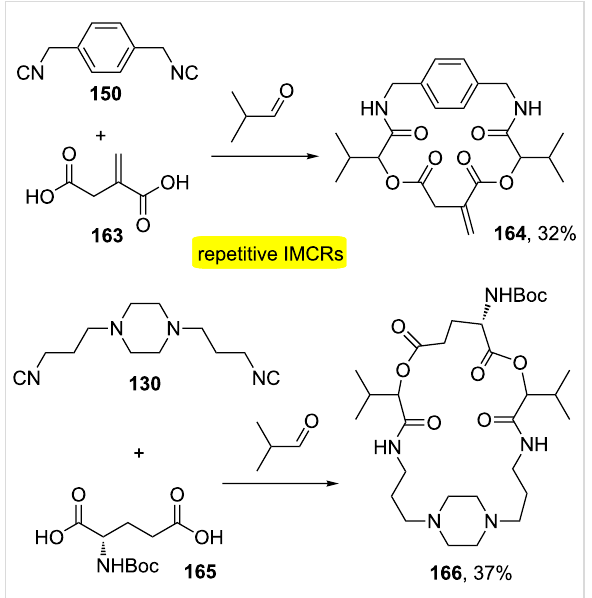
Scheme 32: MiBs based on the Passerini-3CR for the synthesis of macrolactones [49].